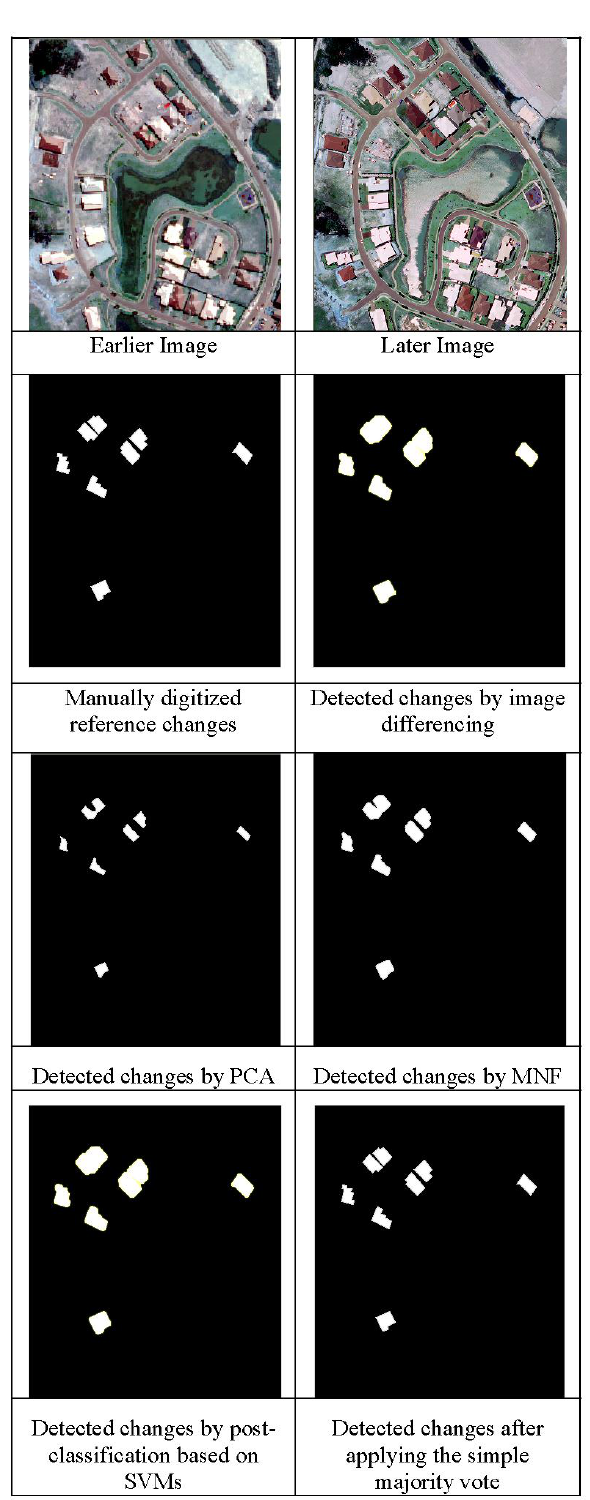
Figure 3. A typical example showing the results in a sub-area of the whole test